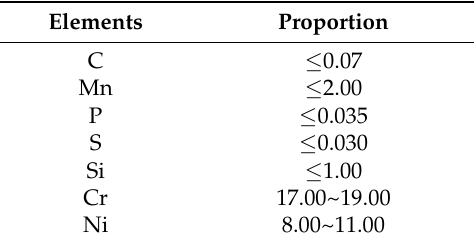
Figure 1. Photos of experimental apparatus. Table 1. Material composition of specimens.